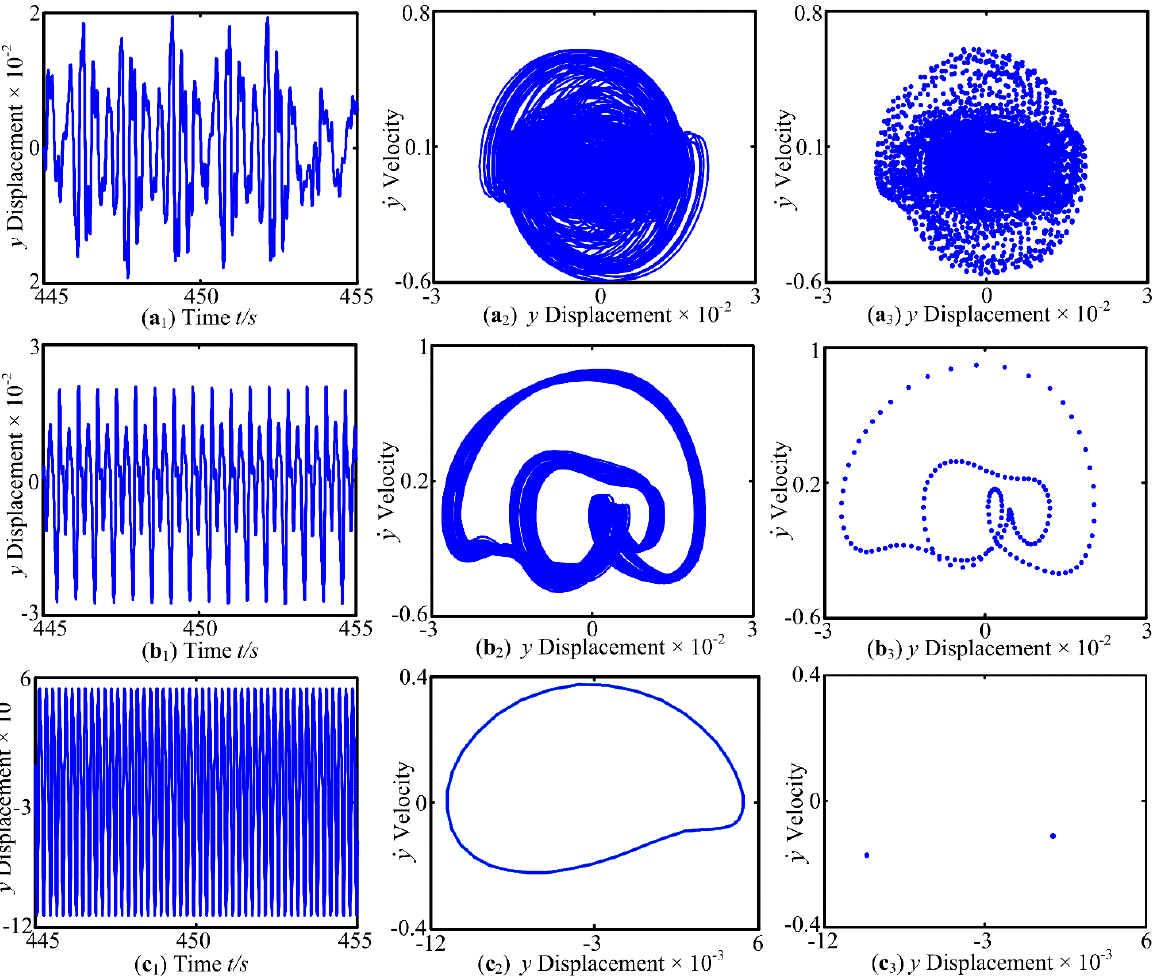
Figure 7. Waveform (1), phase diagram (2) and Poincar é map (3) with µ = 0.426 chaotic motion ( a ), µ = 0.571 quasi-periodic motion ( b ) and µ = 0.576 periodic motion ( c